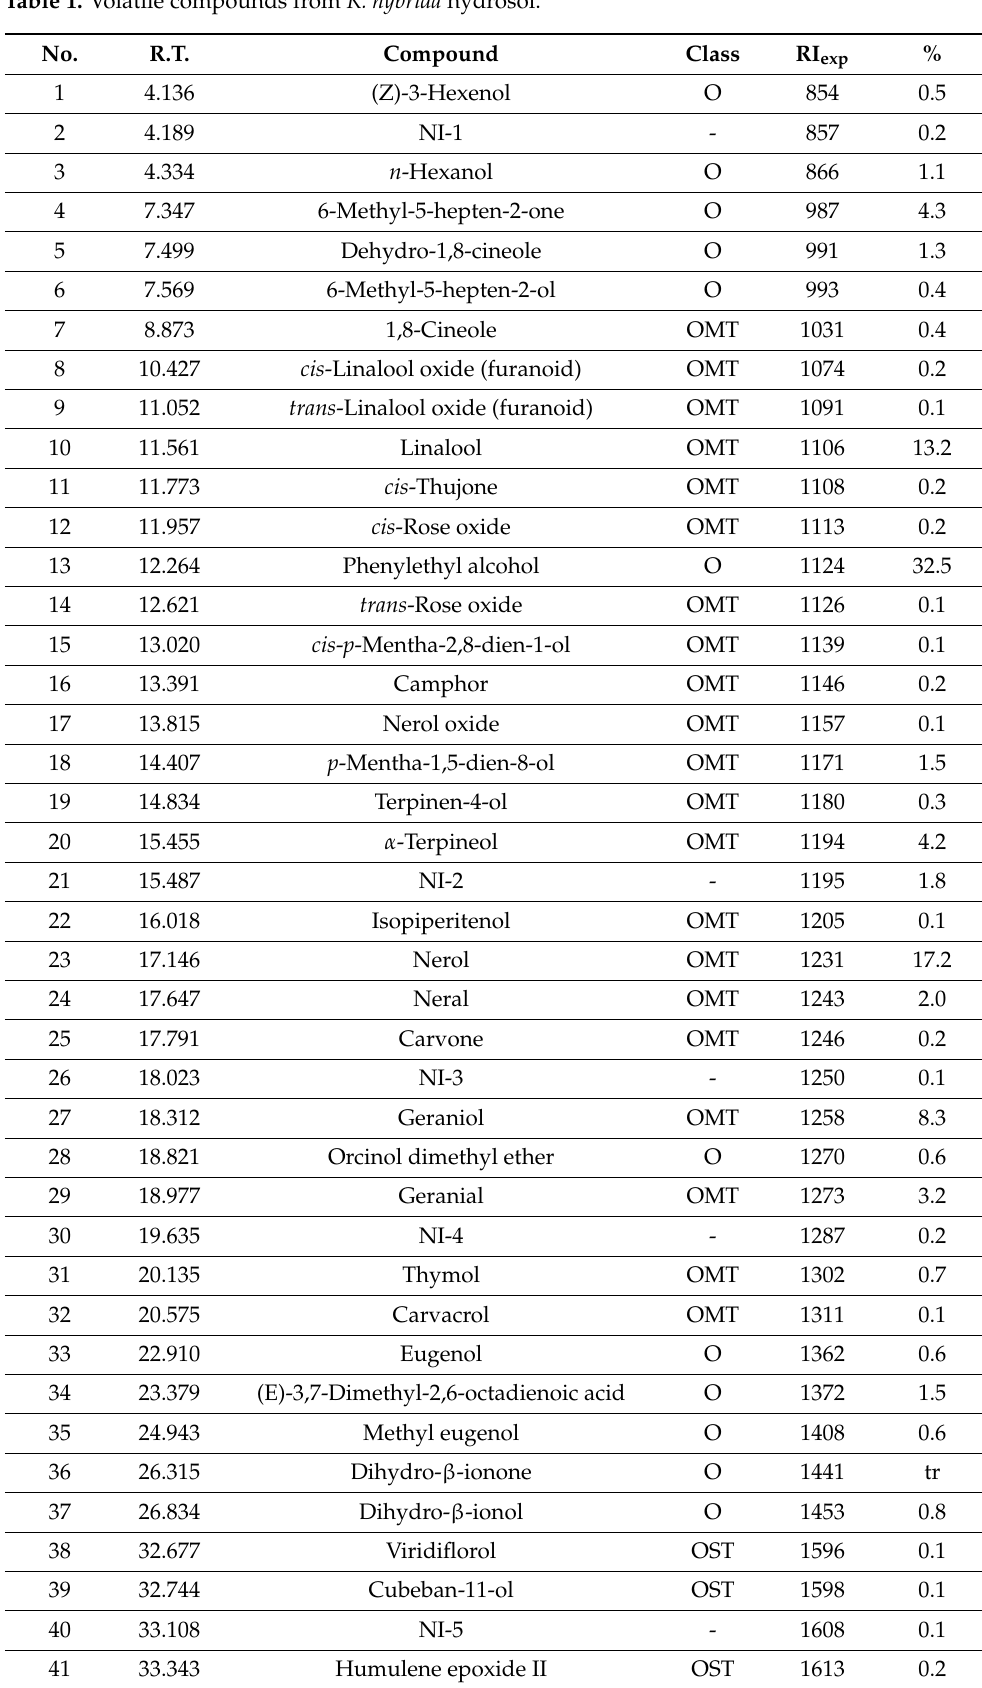
Table 1. Volatile compounds from R. hybrida